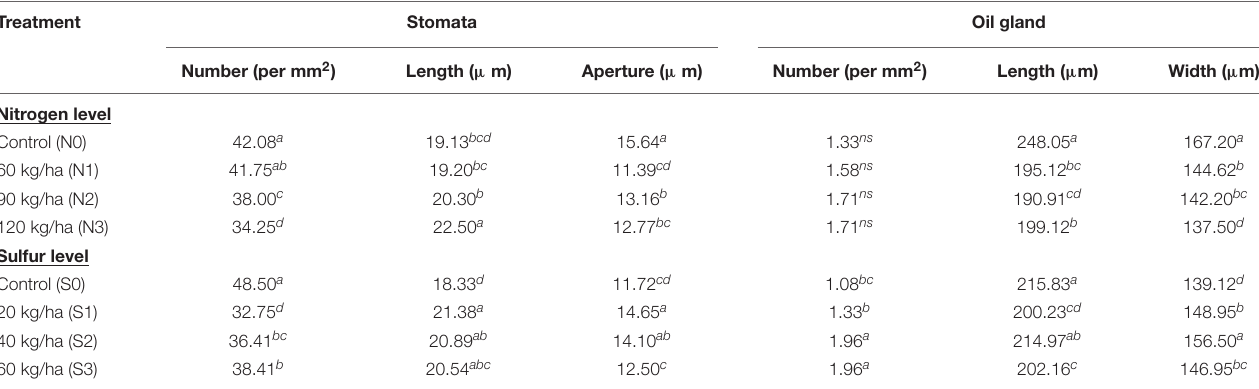
TABLE 4 | Effect of fertilization levels on stomata and oil gland parameters of T. minuta during 2019. Treatment